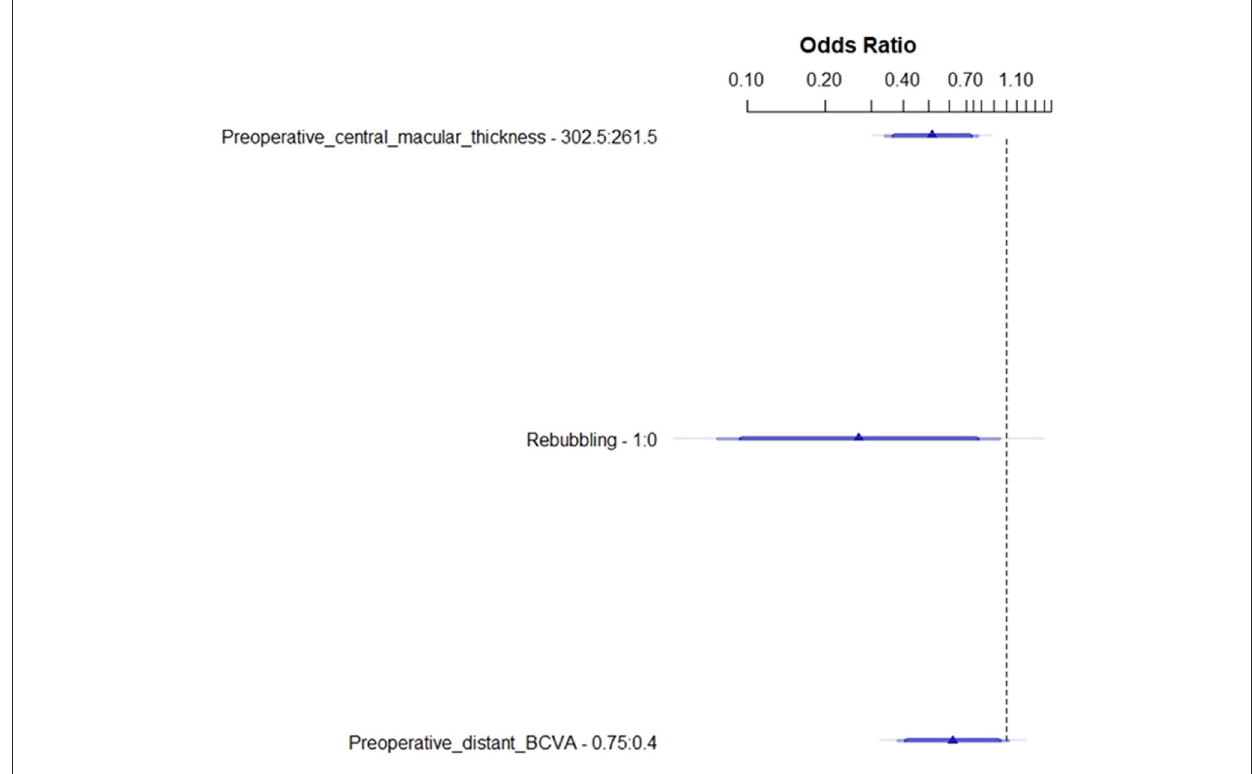
FIGURE3 Forest plot of the main effects in the logistic regression model. Preoperative central macular thickness (OR = 0.517; IC 95% [0.342–0.781]; p < 0.002); rebubbling (OR = 0.269; IC 95 % [0.076–0.949]; p = 0.041); and preoperative distant BCVA (OR = 0.622; IC 95 % [0.379–1.023]; p = 0.061).